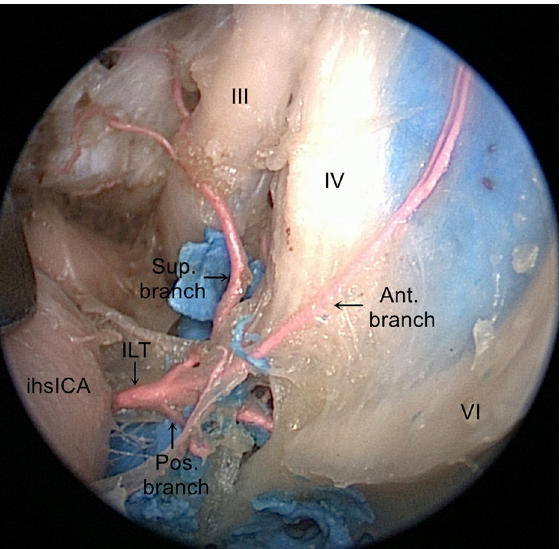
Figure 7. Endoscopic view of the ILT and its branches, the ILT originates from the lateral aspect of the ihsICA, passes above the abducens nerve, and is composed of three branches (superior, anterior and posterior). ihsICA inferior horizontal segments of the ICA, III oculomotor nerve, IV trochlear nerve, VI abducens nerve, ILT inferolateral trunk, Sup.branch superior branch of the ILT, Ant.branch anterior branch of the ILT, Pos.branch posterior branch of the